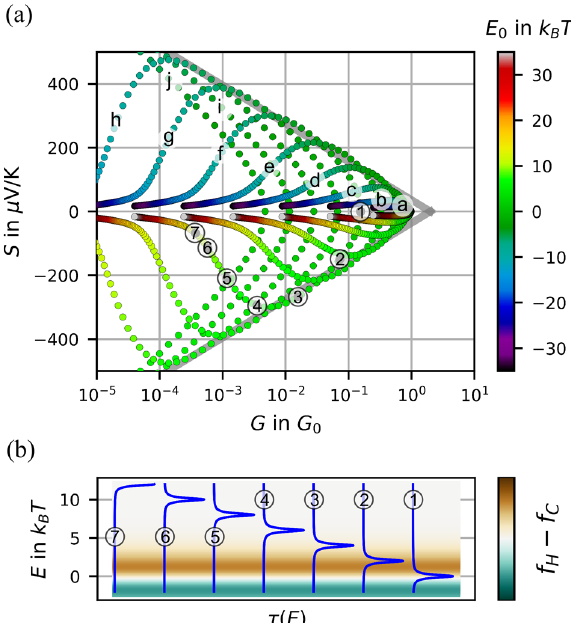
Figure 3. Conductance and Seebeck coefficient in the resonant level model. ( a ) Seebeck coefficients and conductances calculated within the resonant level model. The trajectories a-j are curves of constant Ŵ , varied logarithmically from Ŵ = 10 k B T to Ŵ = 3 · 10 − 3 k B T . Within each trajectory the position of the energy level E 0 was varied in equidistant steps indicated by the color scale. The gray lines are the very same eye guides as in Fig. 2 which mark the boundaries to the excluded area. ( b ) Transmission functions τ( E ) along the trajectory with Ŵ = 1.1 · 10 − 1 k B T . The labels 1–7 correspond to the labels in ( a